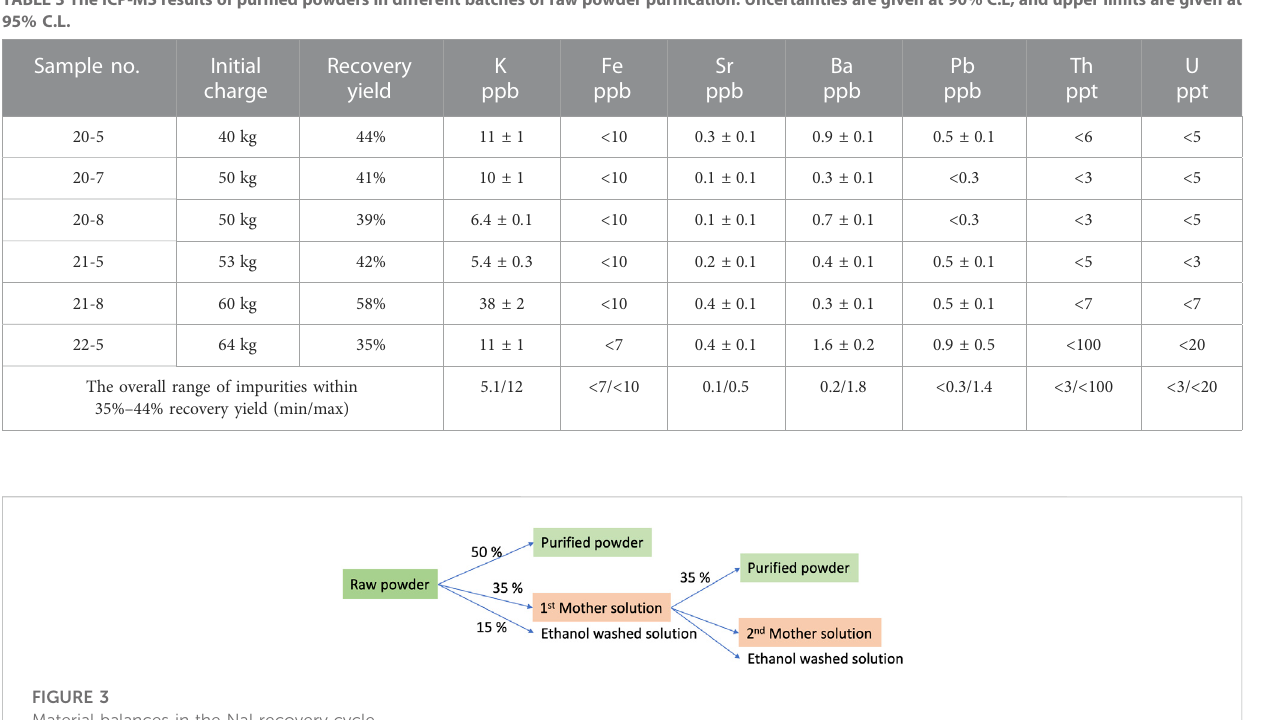
FIGURE 3 Material balances in the NaI recovery